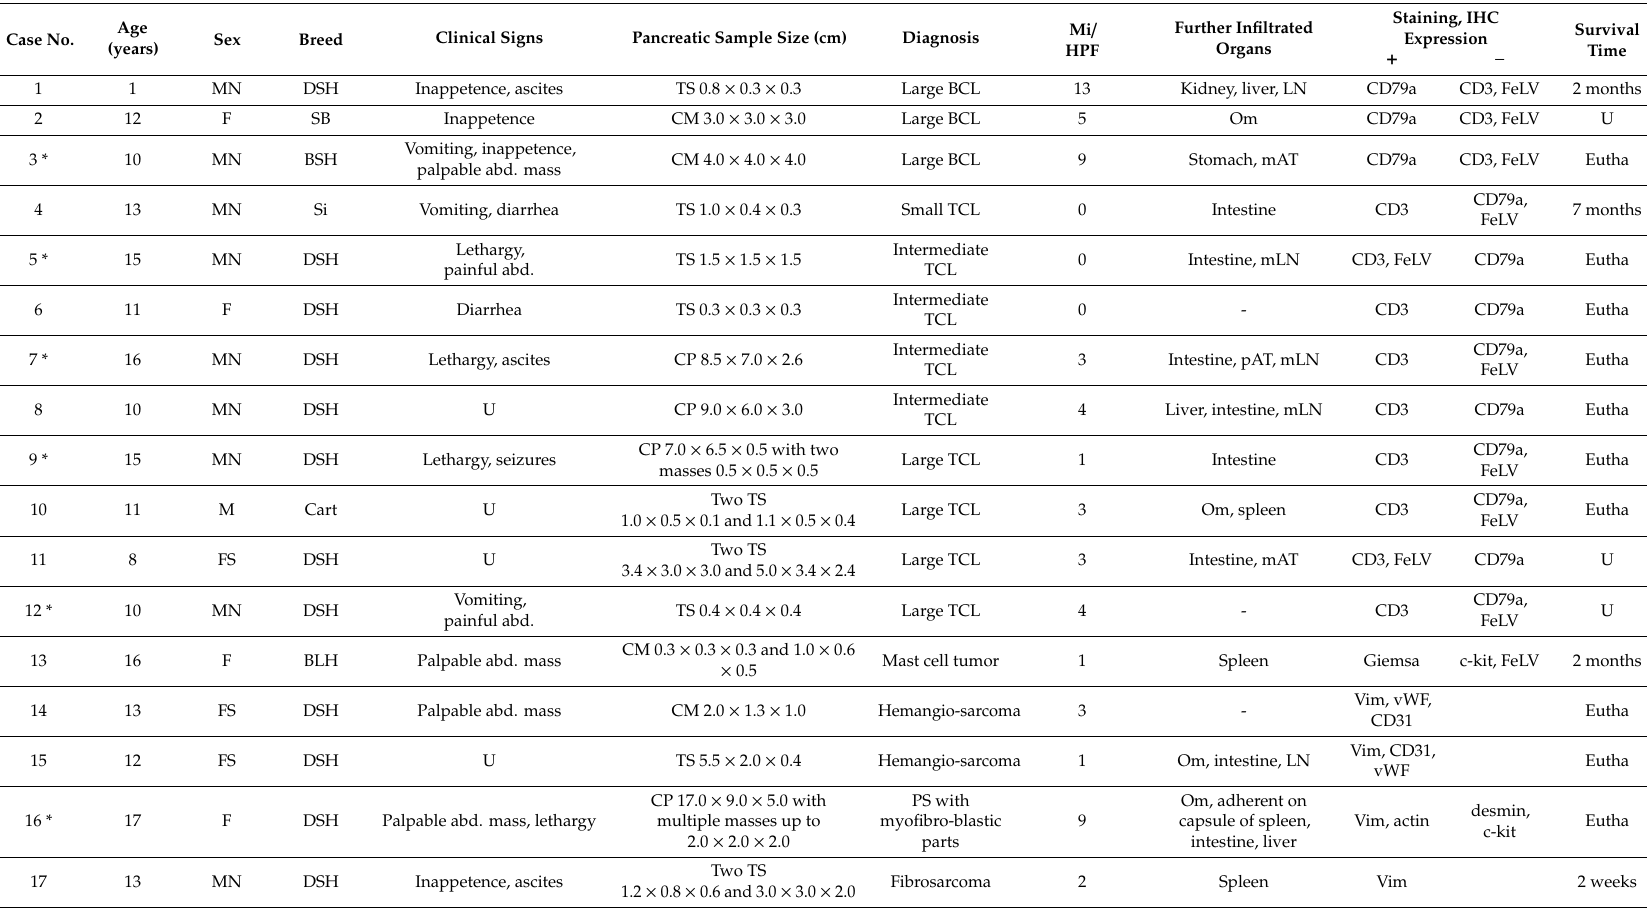
Table 2. Signalment, histopathological / immunohistochemical data and clinical outcome of cats with non-epithelial tumors (n = 17). Case